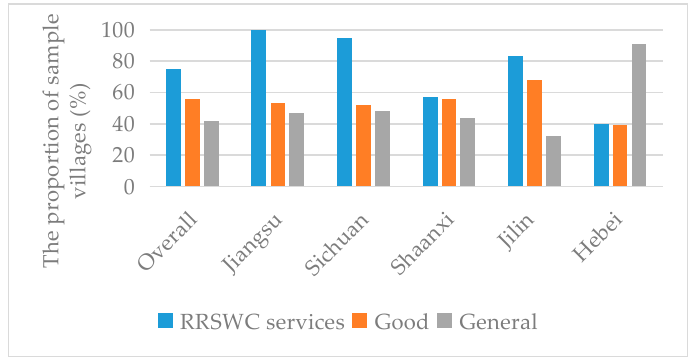
Figure 3. The descriptive statistics analysis results of the variables involved in the model.